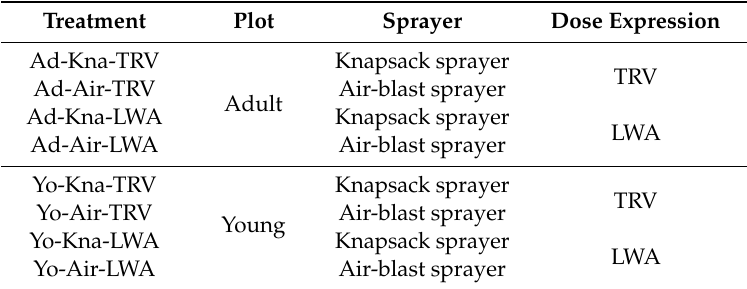
Table 1. Treatments arranged for the field experiments.